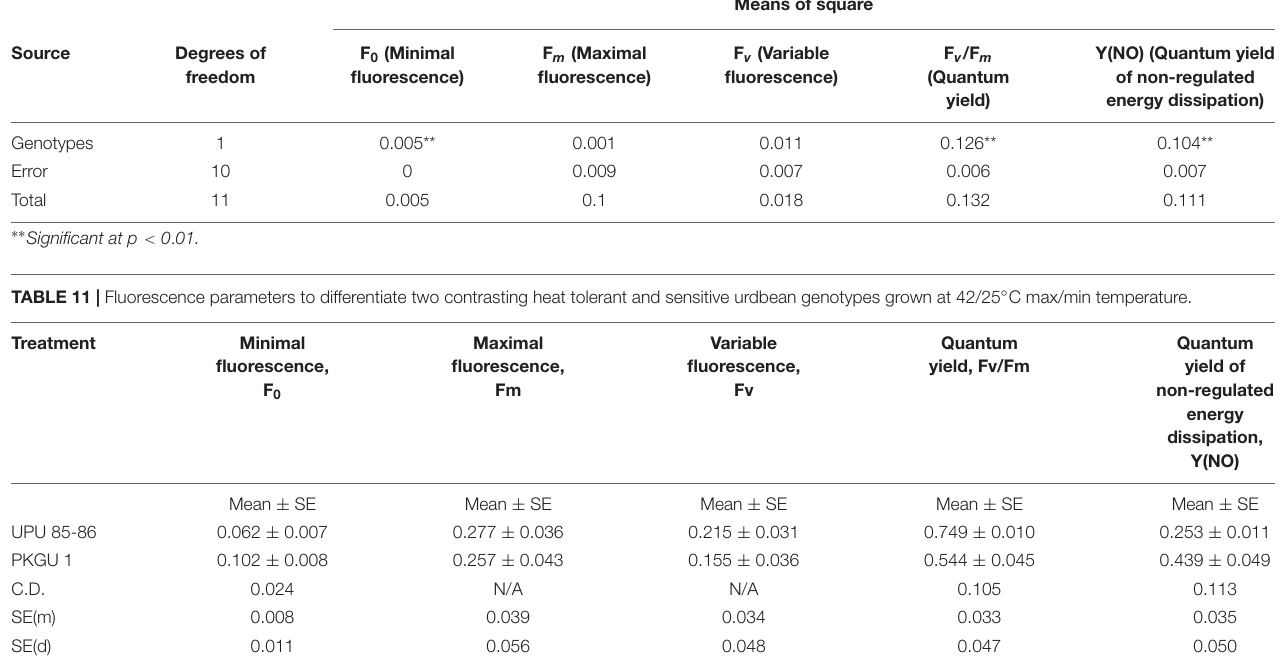
Means of square